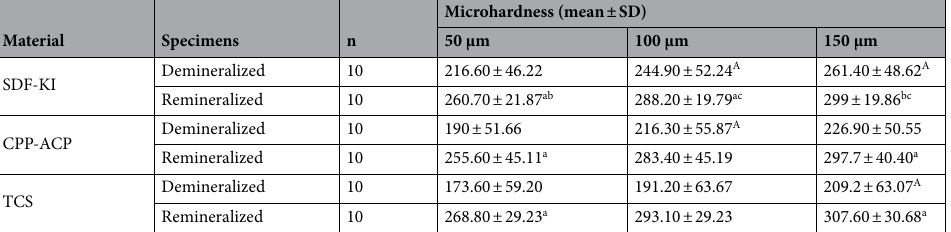
Table 2. Mean ± SD of CSMH of the different groups at different levels. ABC Similar superscript capital letters in the same column denote a significant difference among different materials within the same level on the same side (demineralized/remineralized; p < 0.05). abc Similar superscript lowercase letters in the same row denote a significant difference among different levels within the same material on the same side (demineralized/ remineralized; p < 0.05). $ Non-significant difference between the demineralized and remineralized specimens for the same level in the same